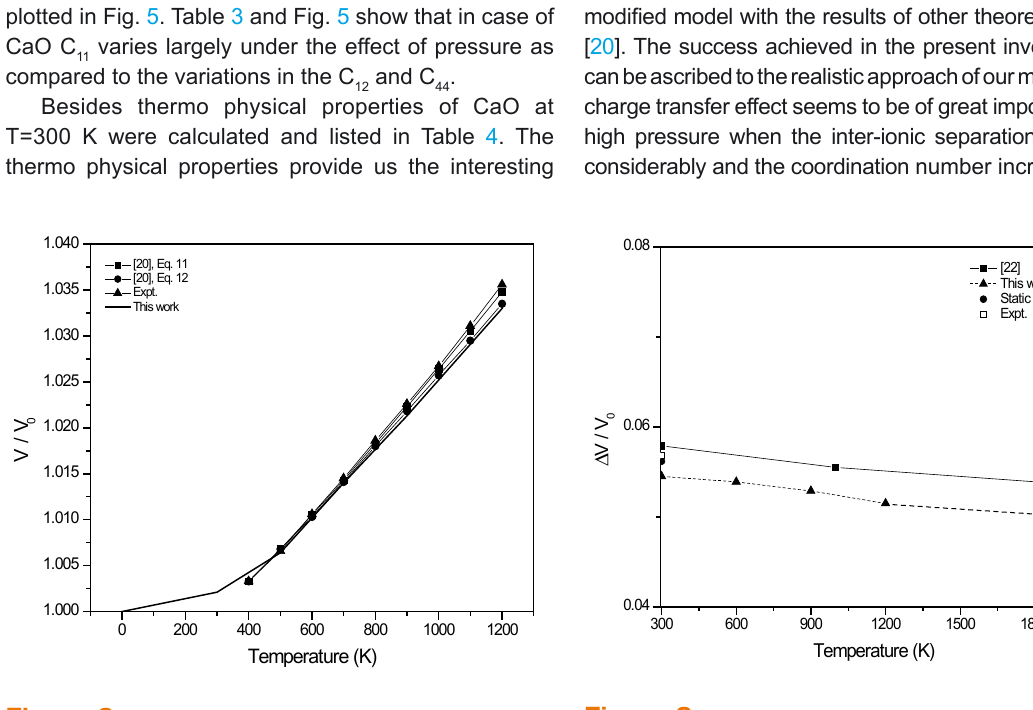
/V with temperature. Figure 3. Variation of Δ V/V P 0